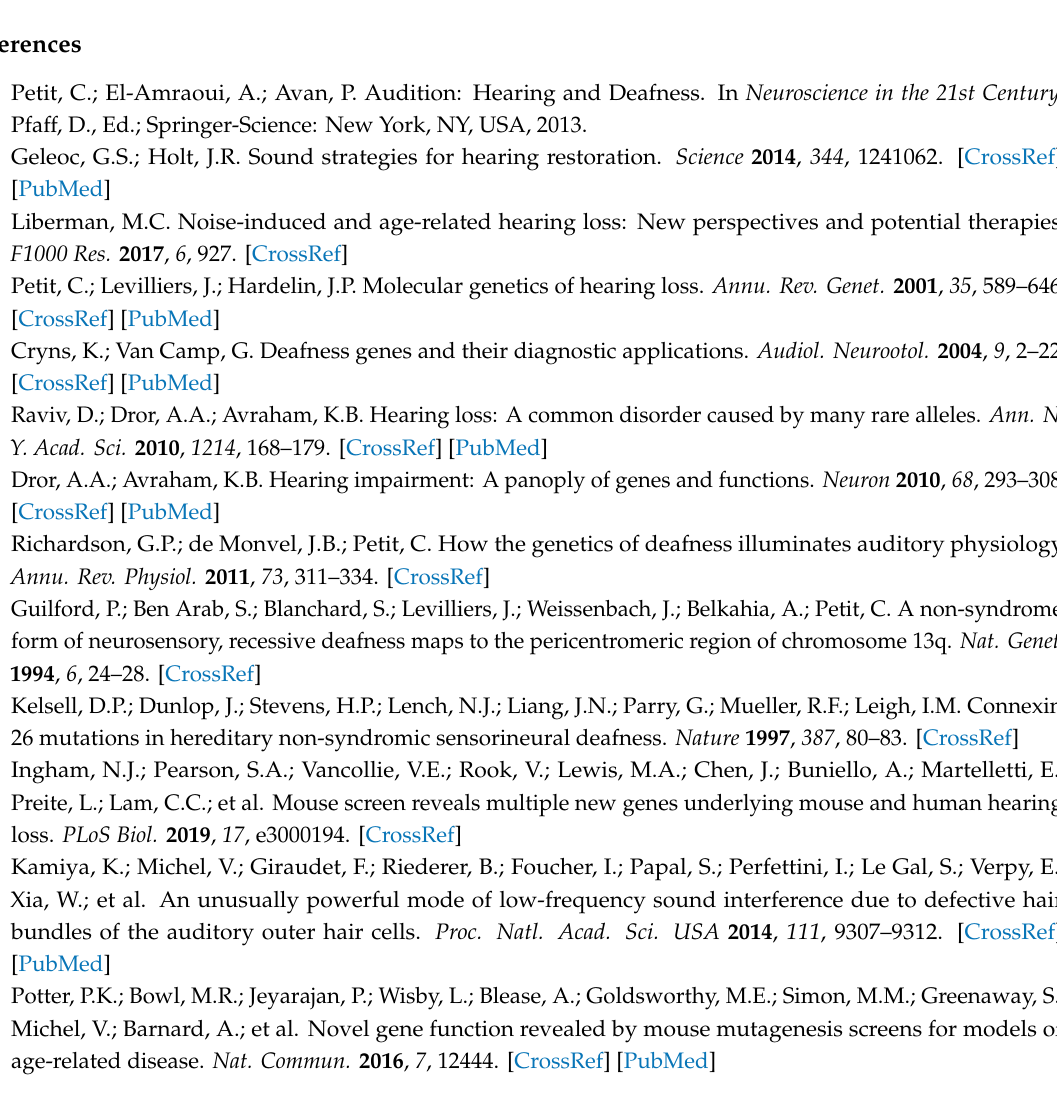
Table S1: Non-syndromic hearing loss loci and genes in human. Table S2: Comparison of di ff erent routes of delivery to the inner ear. Table S3: Adeno-associated virus (AAV) vectors used in inner ear gene therapy studies. Author Contributions: S.D. and A.E.-A. wrote the manuscript. All authors have read and agreed to the published version of the